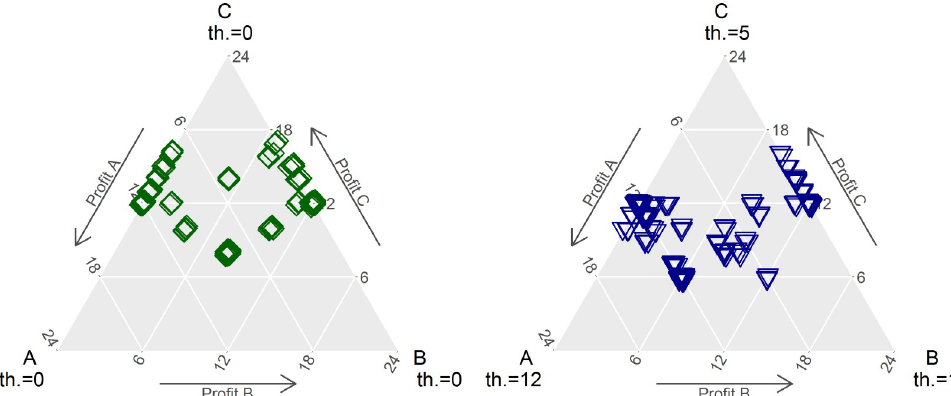
Fig 1. (A and B). Distribution of allocation agreements (accepted offers). Panel A: Scenario c0–0–0. Panel B: Scenario c5-12-1. The nodes of the graph denote the positions of the players: C is the central player, A and B are the peripherals. Thresholds are denoted below the label of the positions, whereby Panel A displays the scenario c0-0-0 and Panel B c5-12- 1. The arrows aside the graphs indicate each player’s payoff: The closer a mark to the position, the higher her share of the allocation decision. There is a notable difference in clusters of allocations between the scenarios presented. The cluster at the centroid denotes an equal split between all three subjects. Marks are slightly jiggled in order to visualize local clusters of player